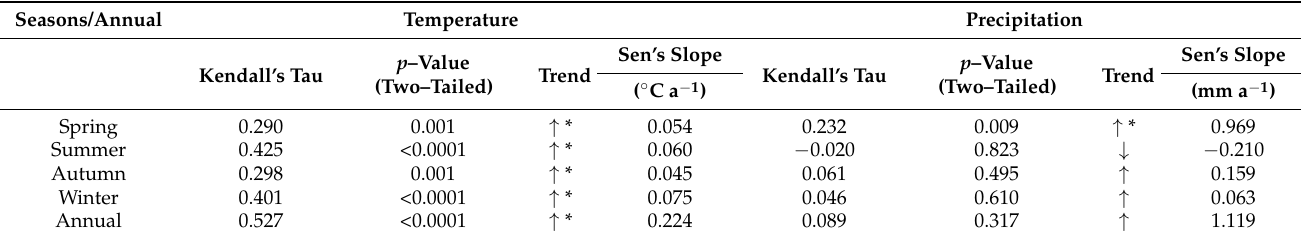
Table 8. Mann–Kendall test for statistical trend analysis of long-term temperature and precipitation over the period 1960–2019. Sen’s Slope (Q) analysis shows the rate of change in temperature ( ◦ C a − 1 ) and precipitation (mm a − 1 ). Seasons/Annual